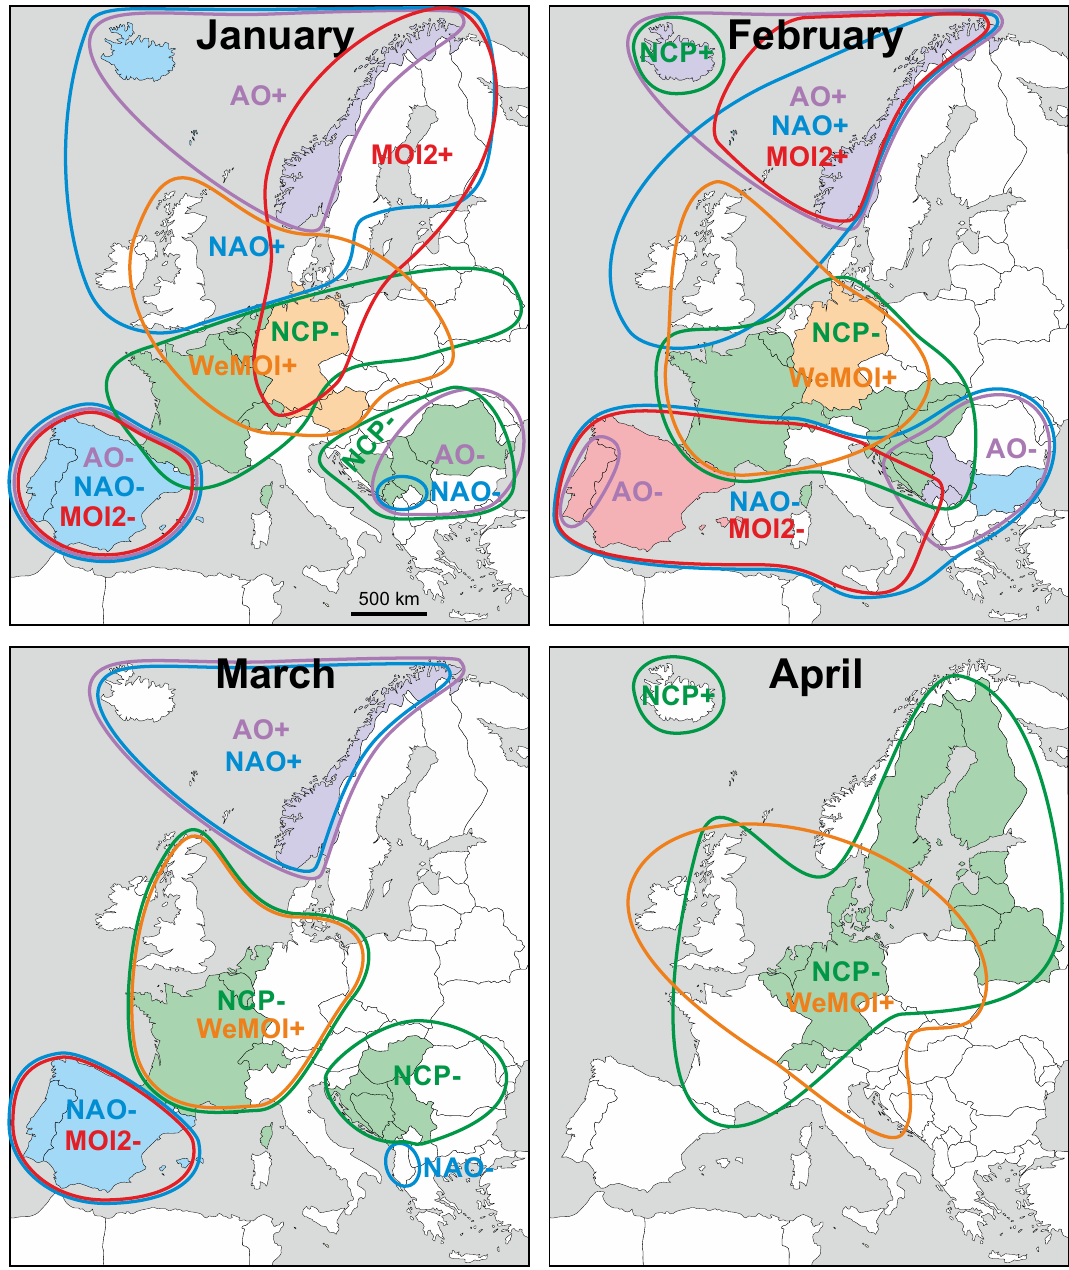
Figure 3. Monthly maps showing regions in which rainfall correlated with atmospheric indices with r ≥ 0.50/ ≤ − 0.50 (coloured framing) and r ≥ 0.60 / ≤ − 0.60 (coloured filling). The plus/minus signs to the right of the atmospheric indices denote positive and negative correlations with rainfall (e.g. NAO+ and NAO−, not to be confused with the positive and negative phases of the index). The colours are: NAO = blue, AO = purple, NCP = green, MOI2 = red, WeMOI = orange. The geographical base map of Europe was retrieved from https:// www.d- maps. com/ carte. php? num_ car= 2232& lang= en. Detailed correlation maps and statistical results tables are provided in the supplementary Figs. S1–S5 and Tables